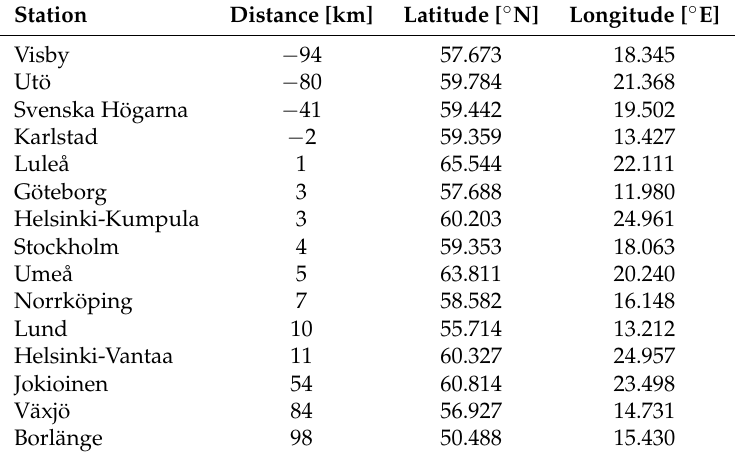
Table 1. Solar radiation measurement stations included in this study arranged according to their distance to the coastline. Negative distances indicate locations